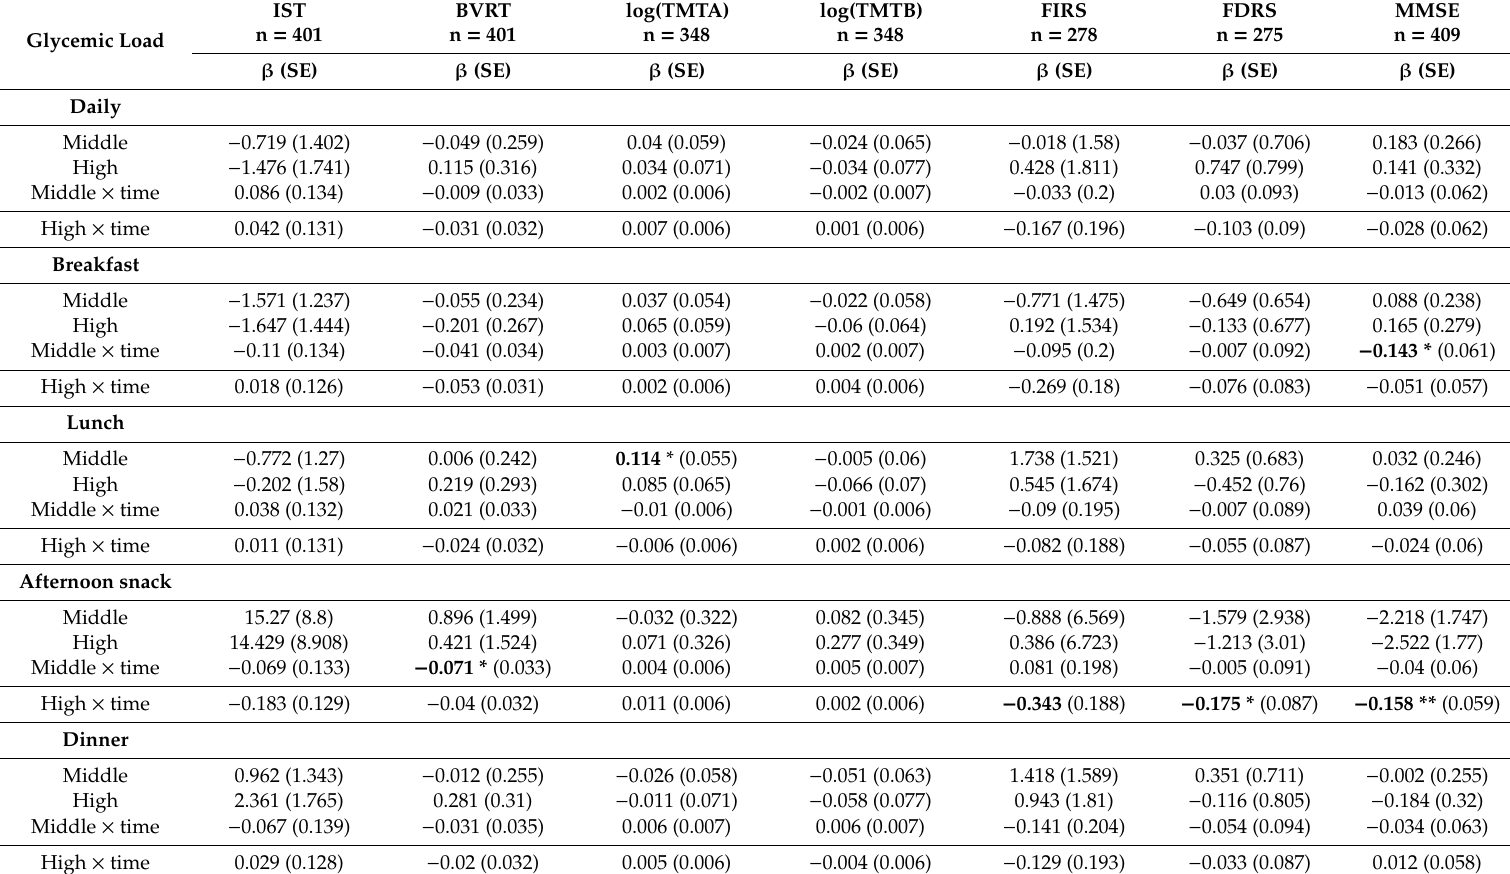
Table 3. Associations of glycemic load with cognitive change in APOE4 carriers (12-year